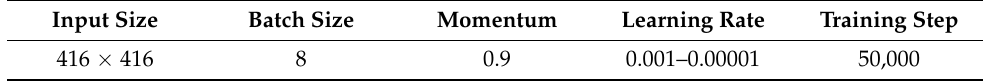
Table 5. The initialization parameters of